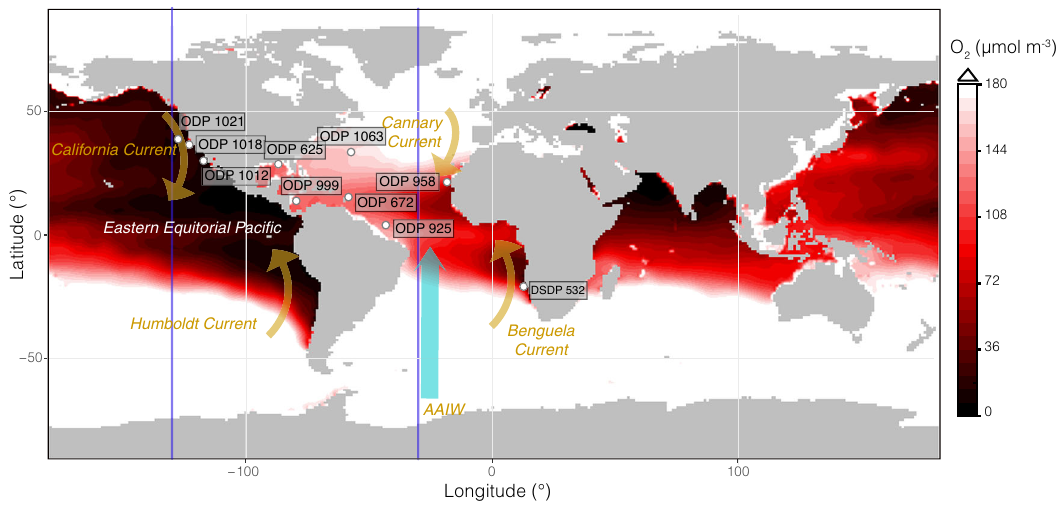
Fig. 1 | Distribution of low-oxygen mid-waters in the modern ocean. Minimum O 2 withintheupper1000mfromWOA18data(1955 – 2010) 90 isshownwithlowerO 2 concentrations in darker red. Regions where oxygen concentrations do not fall below 172 μ mol m -3 are white. Dark blue lines show the location of sections